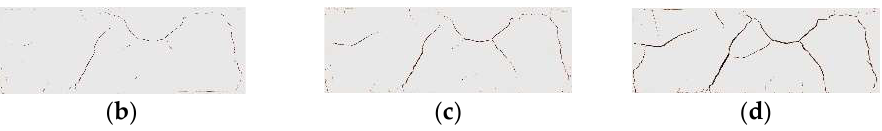
Figure 3. Cracking of specimens with a size of 30 cm × 10 cm × 2 cm. ( a ) Initial stage; ( b ) crack development stage; ( c ) crack development stage; ( d ) final crack morphology.